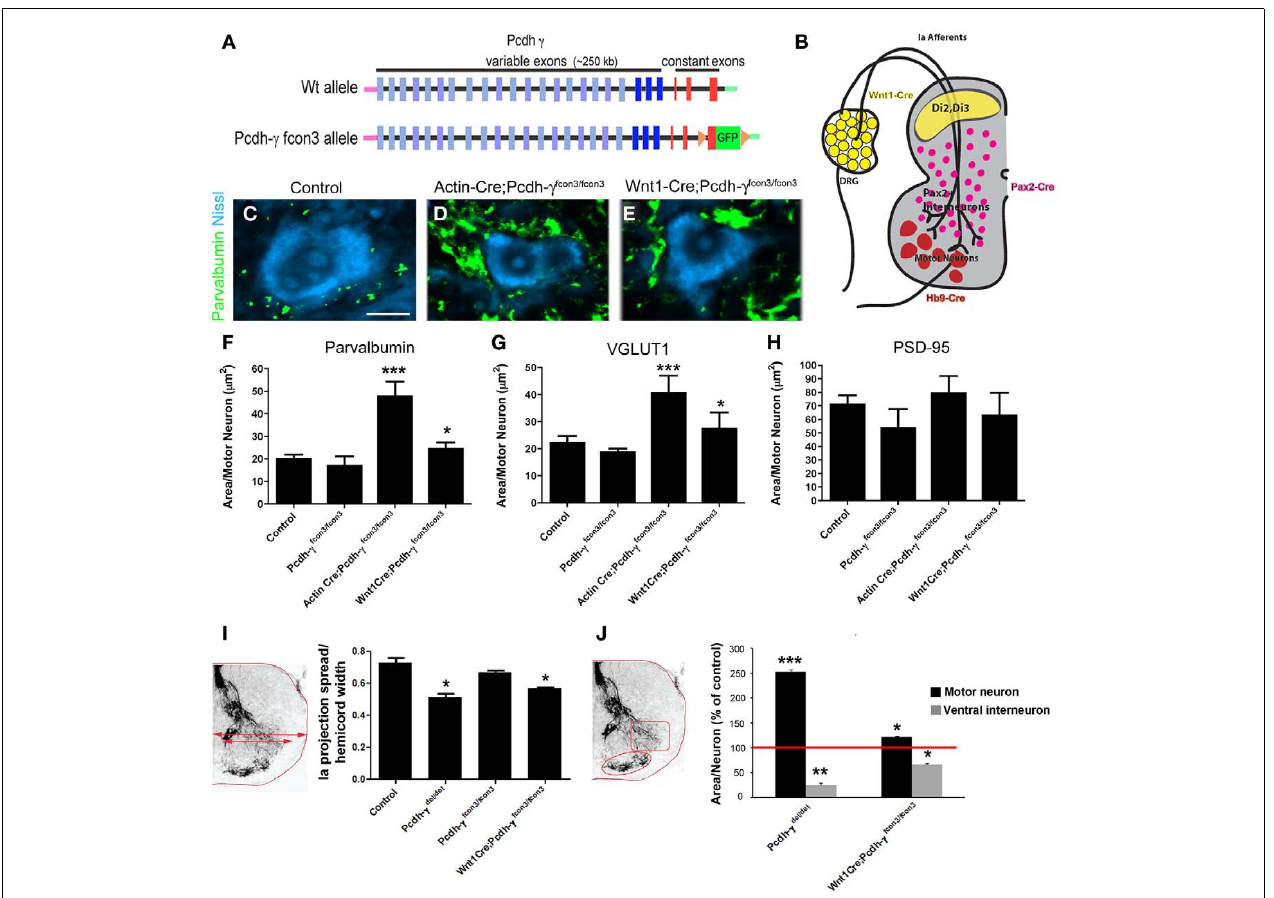
FIGURE 7 | Restricted mutation of the Pcdh- γ gene cluster in DRG sensory neurons reveals a cell autonomous requirement for the γ -Pcdhs in Ia afferent terminal arborization. (A) Schematic diagram showing the wild-type (wt) and conditional mutant Pcdh- γ alleles ( Pcdh- γ fcon3 ).The fcon3 alleles harbors loxP sites on either side of the third constant exon to which GFP is fused. (B) Schematic diagram of a P0 spinal hemi-cord showing the neuronal subsets in which the Pcdh- γ gene cluster is disrupted when crossed with the indicated Cre transgenic lines. (C–E) Individual motor neurons from control, Actin-cre ; Pcdh- γ fcon3/fcon3 (ubiquitous excision) and Wnt1-Cre ;